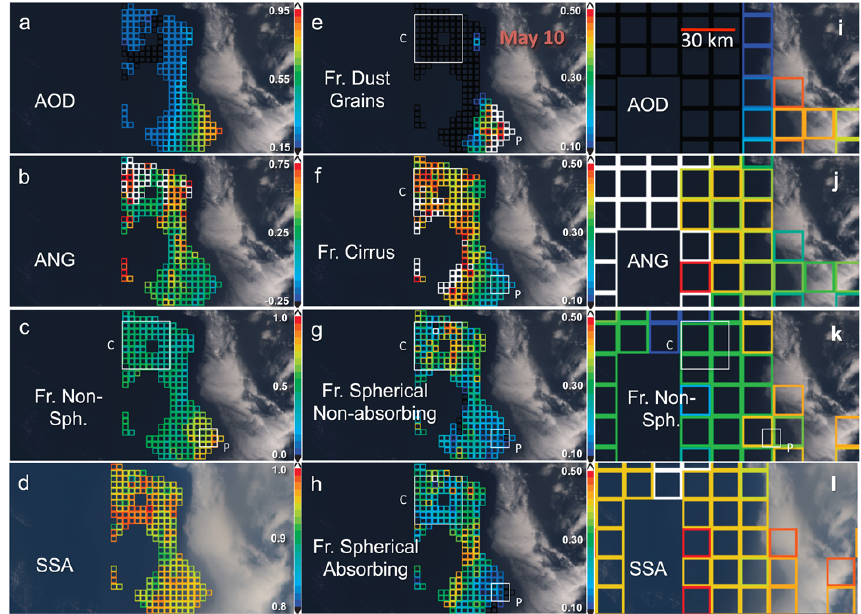
Fig. 7. (a–h) Same as Fig. 3, but showing results for the 10 May 2010 plume in the central North Atlantic. North is roughly toward the top. The elevation of the ash plume could not be determined from stereo imaging, so the multi-angle images were co-registered to the nearby cloud elevation of 1.25km; the surface wind speed was set to 2.5ms − 1 . The χ 2 threshold for the patches in this image was set max3 at p min + 0 . 1. (i–l) MISR Standard V22 retrieval results, at 17.6km resolution, presented using the same color scale as the corresponding Research Retrieval quantities in Panels (a–d) . The locations of the plume (P) and control (C) patches are indicated in Panels (c) , (e–h) , and (k) to facilitate